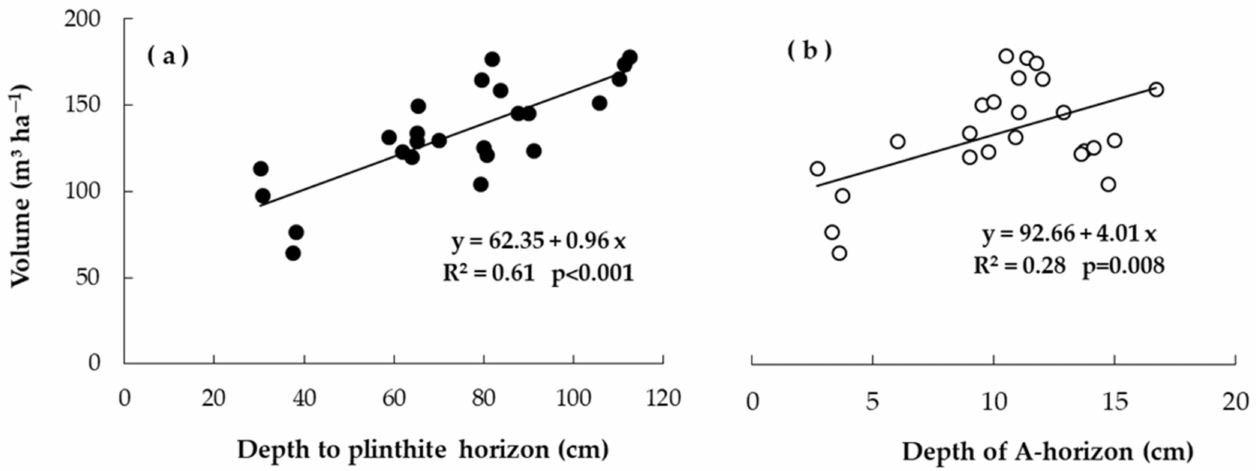
Figure 8. Eucalyptus pellita at age 6 years: relationship between stem volume and ( a ) depth to plinthite horizon, ( b ) depth of A-horizon. Data points represent individual plots of P-0 treatment from all replications and six